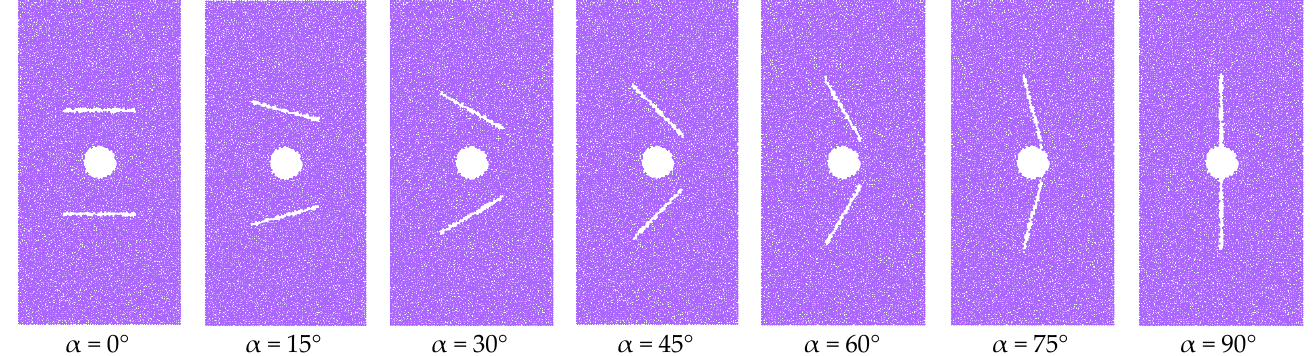
Figure 3. The establishment of seven numerical models with different crack angles.